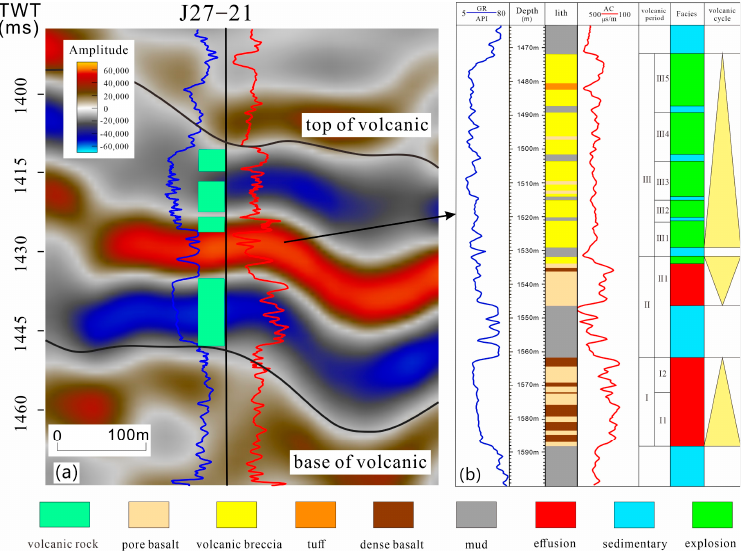
Figure 8. Division results of volcanic eruption stages in Jun 27–21. ( a ) Jun 27–21 seismic profile; ( b ) division of volcanic eruption periods of well Jun 27–21.